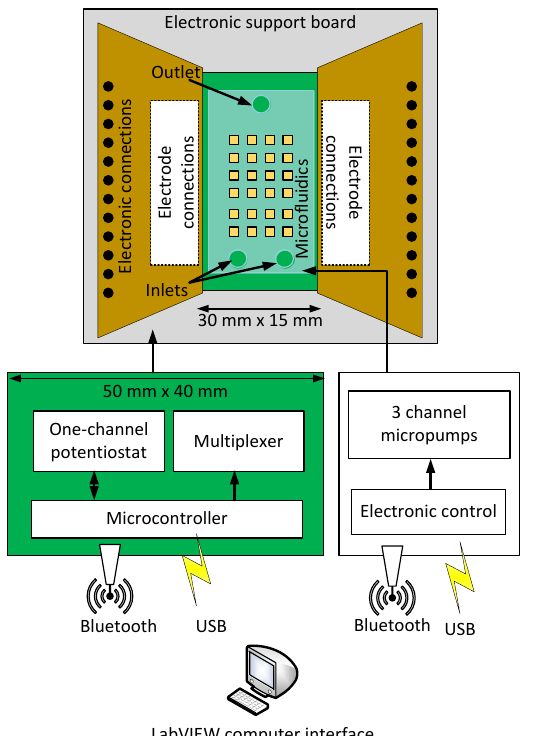
Figure S3. Multifunctional LoC diagram. All modules can interface with each other’s through a LabVIEW interface. They can handle both wireless and USB communications depending on the application. All modules of the LoC were independently controlled by the LabVIEW interface as shown at Figure 8. The software is extremely automated so that if any reservoir is going to be empty its corresponding micropumps is automatically stopped. The potentiostat interface monitors each sensing channel, which could be set with different sensitivities. The electrode array control interface was able to connect each channel of the potentiostat to any electrode in the microfluidic chamber or other electrode connected externally to the